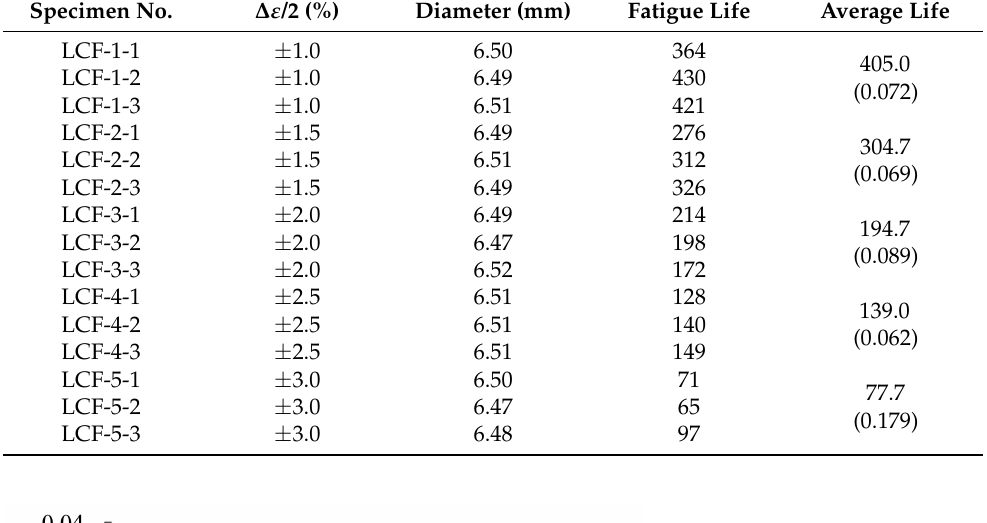
Table 3. Test results of the low cycle fatigue.